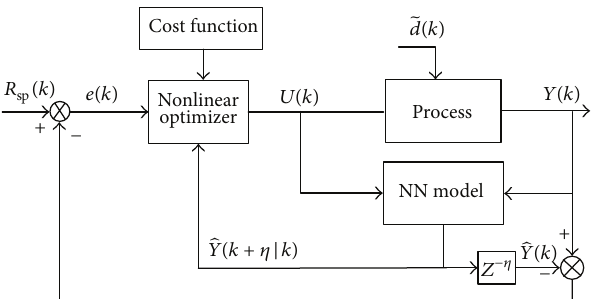
Figure 3: ADNMPC structure based on DNN for the pickling Ti strips